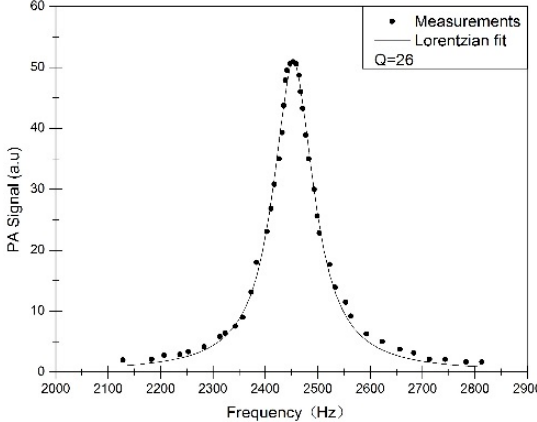
Figure 4. The resonance profiles showing the first longitude resonance frequency is 2450 Hz.